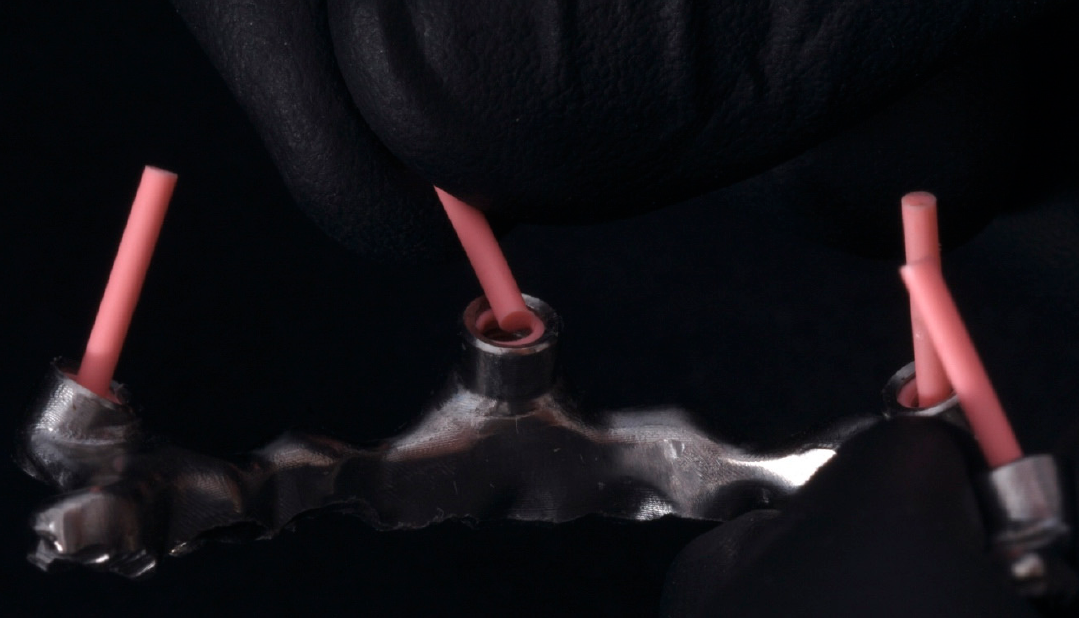
Figure 12. Inserting the Seeger and taking away the carrier.